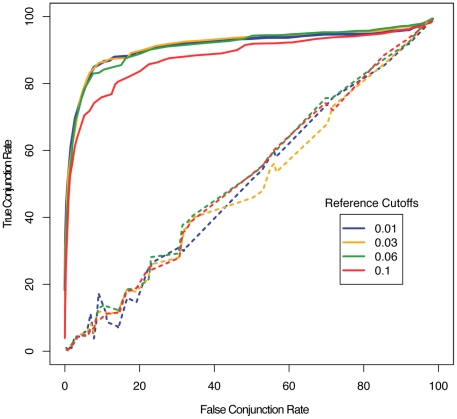
Relationship between false clustering rate and true clustering rate.Each read data set was clustered into OTUs at various thresholds and compared to the corresponding full-length data set, which was clustered at several fixed PD thresholds (shown here are full-length sequence cutoffs of 0.01, 0.03, 0.05 and 0.1). For each full-length sequence threshold, the true conjunction and false conjunction rates of the read OTUs were calculated as a function of the read threshold. Solid lines represent the median value of the true and false conjunction rates across simulations. Dashed lines represent the median value of the true and false conjunction rates derived from comparisons of randomly permuted clusters relative to the source sequence clusters.